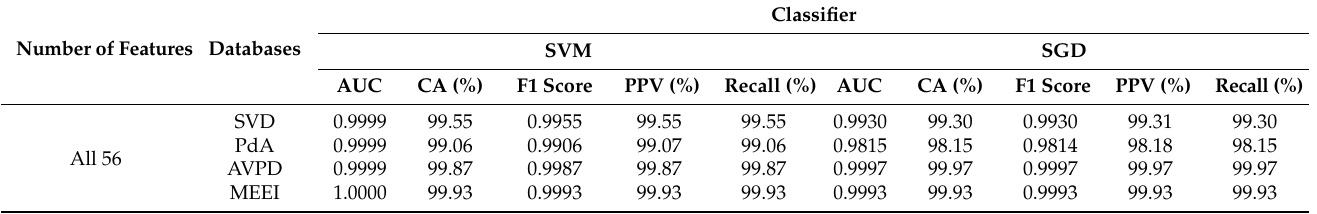
Table 4. Performance indicators for SVM and SGD classifiers for trials identifying vocal